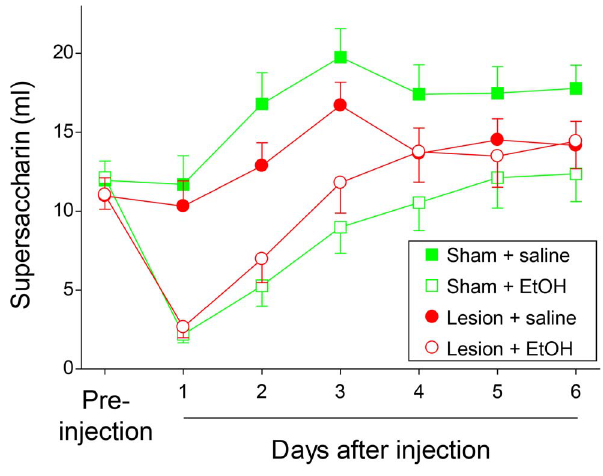
Figure 6. Ethanol induced conditioned taste aversion. LHb lesion attenuated the magnitude of a taste aversion conditioned by a single injection of ethanol. X-axis shows intake of supersaccharin; y-axis shows time of saccharin intake relative to injection in days. Squares and circles indicate sham- and LHb-lesioned rats, respectively. Filled and open symbols indicate saline and ethanol injection groups,